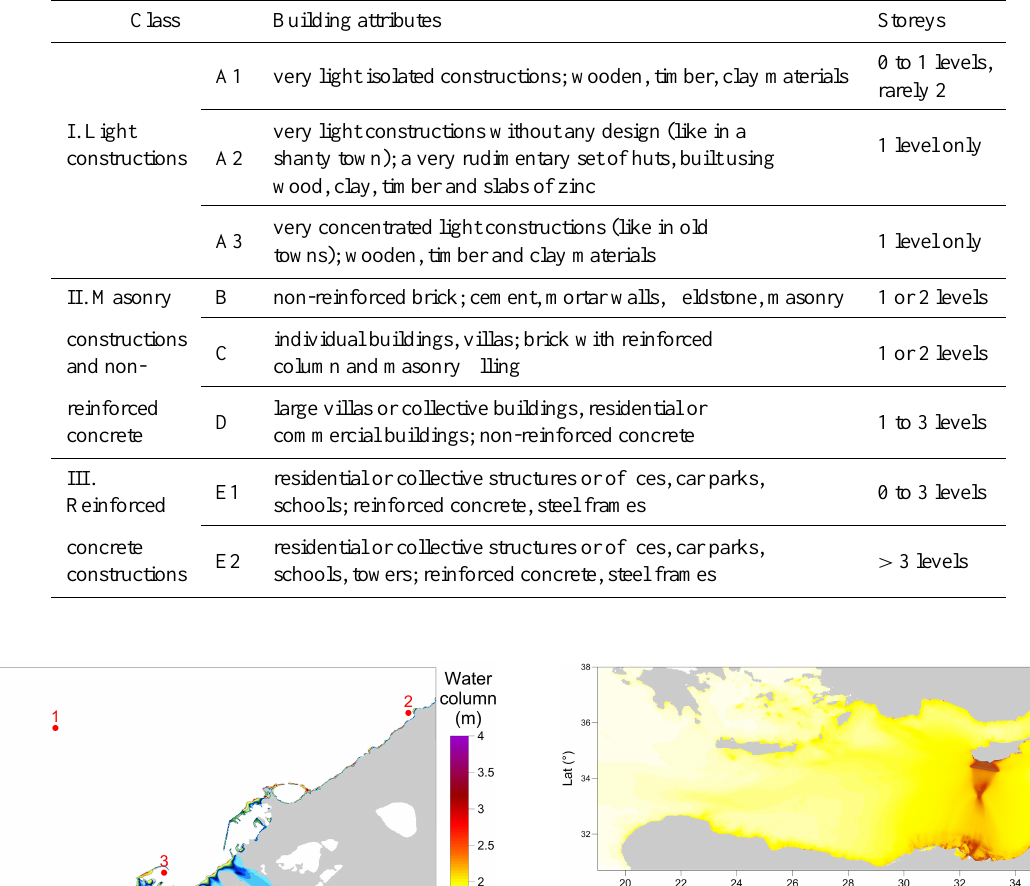
Table 3. Building classes according to the project SCHEMA (Valencia et al., 2011). Any reference to building exposure is removed. Class Building attributes Storeys